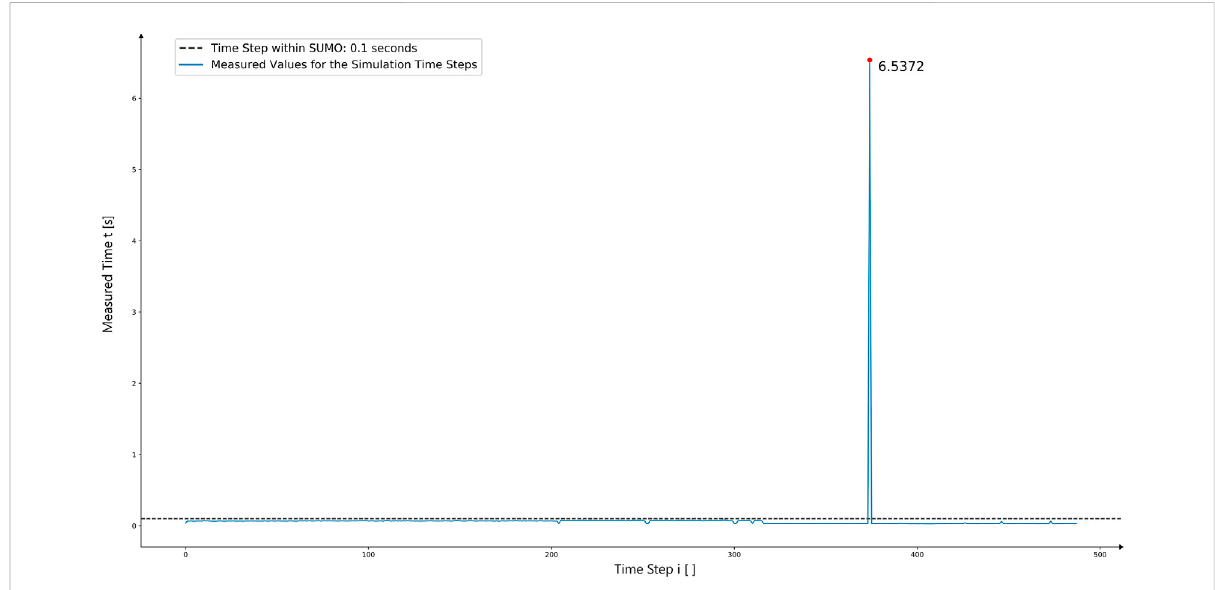
FIGURE 15 Showing the duration of the different controlling steps during the simulation for scenario 3 against the time step duration threshold within SUMO, which was chosen to be 0.1